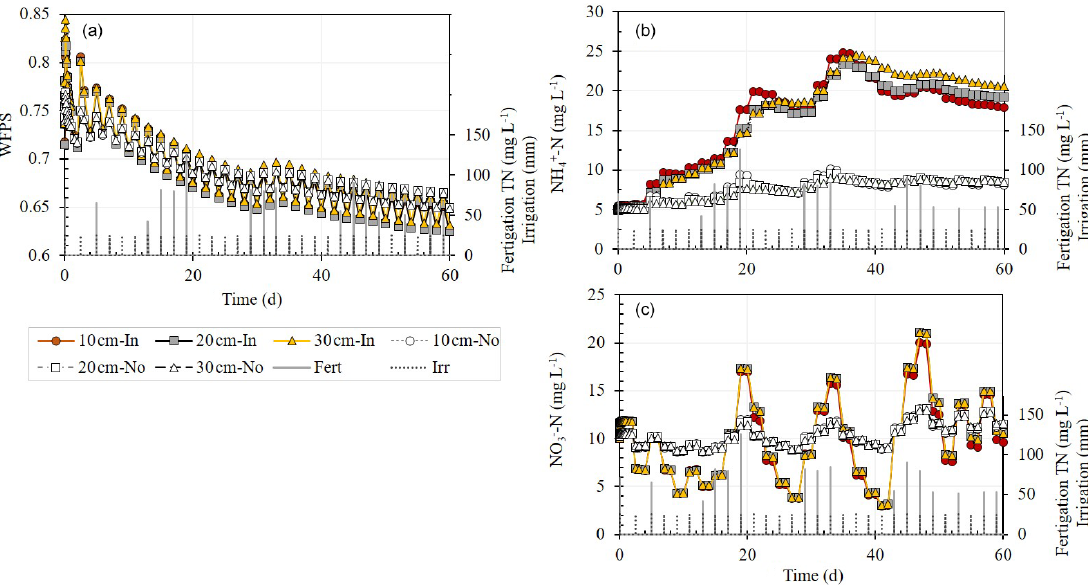
Figure 3. Simulation results of the change over time in (a) water-filled pore space (WFPS), (b) NH + three depths (10, 20, and 30cm) under a base of a static chamber with a dripper at its center (filled shapes – In) and under a dripper without a base (light empty shapes – No) following irrigation every other day, and fertigation events. The top right corner of (a) shows a zoom-in of the WFPS cycle during 3 consecutive days: the day after fertigation (day 14), the day of fertigation (day 15), and the day following the fertigation event (day 16). Total nitrogen (TN) concentration in the fertigation solution is the sum of NO −